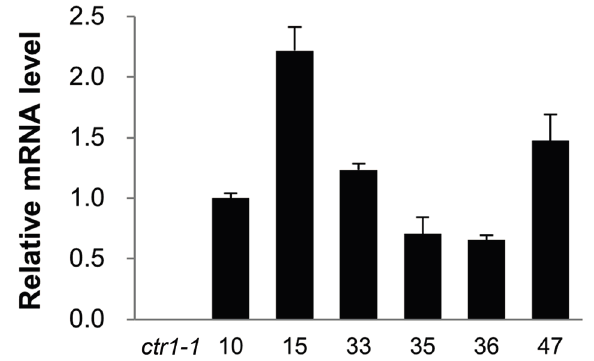
Figure 4. Expression analysis of CsCTR1 in Arabidopsis transgenic line 10, 15, 33, 35, 36, 47 and ctr1-1 mutant by quantitative real-time PCR. Each result was the average of three independent biological replicates. Error bars on each column indicate standard deviation from three